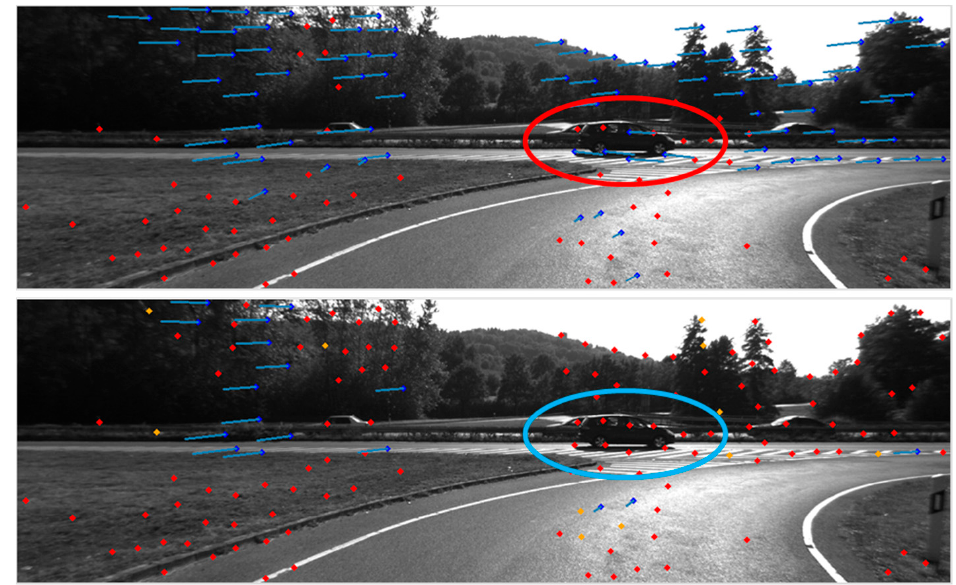
Figure 8. Top: before optimization (top image). Bottom: after optimization (sequence 01; frame 02).